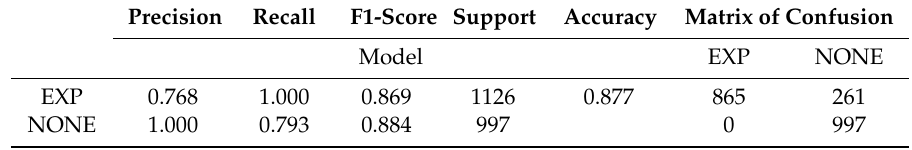
Table 6. Confusion matrix and evaluation criteria for the binary discrimination model using SUM ( β )